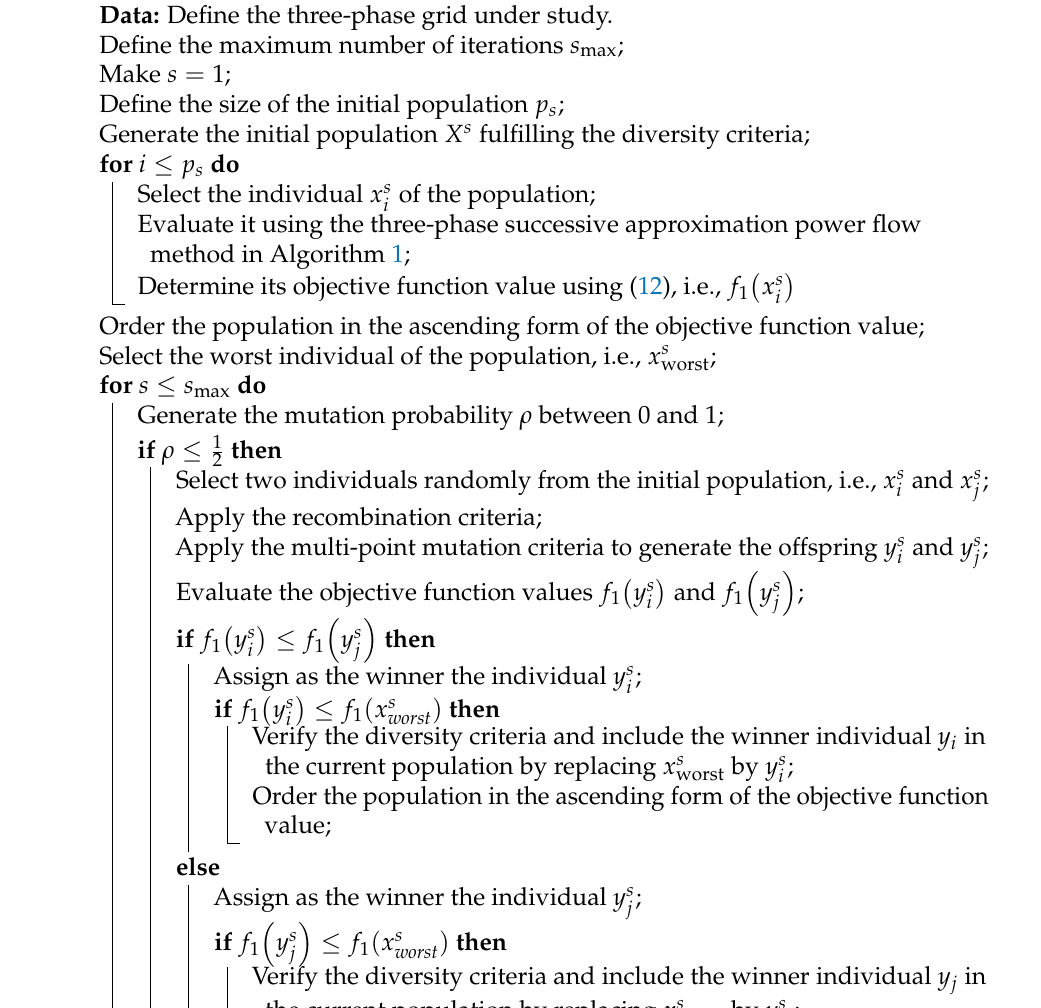
Algorithm 2: Improved CBGA for solving the phase-balancing problem in three- phase unbalanced distribution